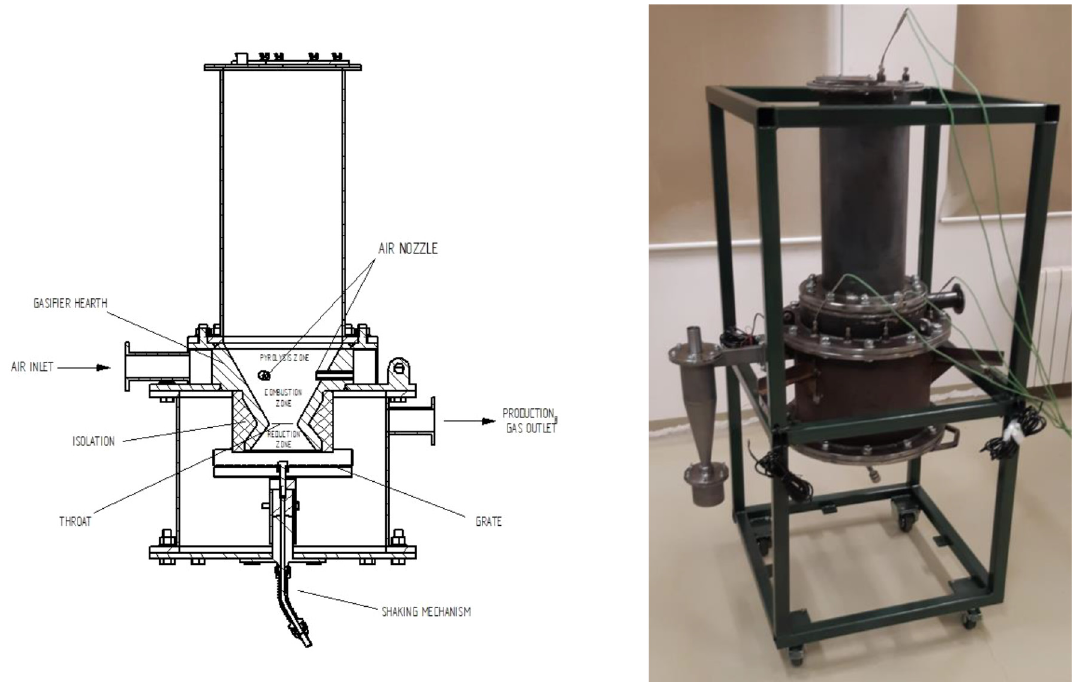
Fig. 4. The Imbert type downdraft gasi fi er